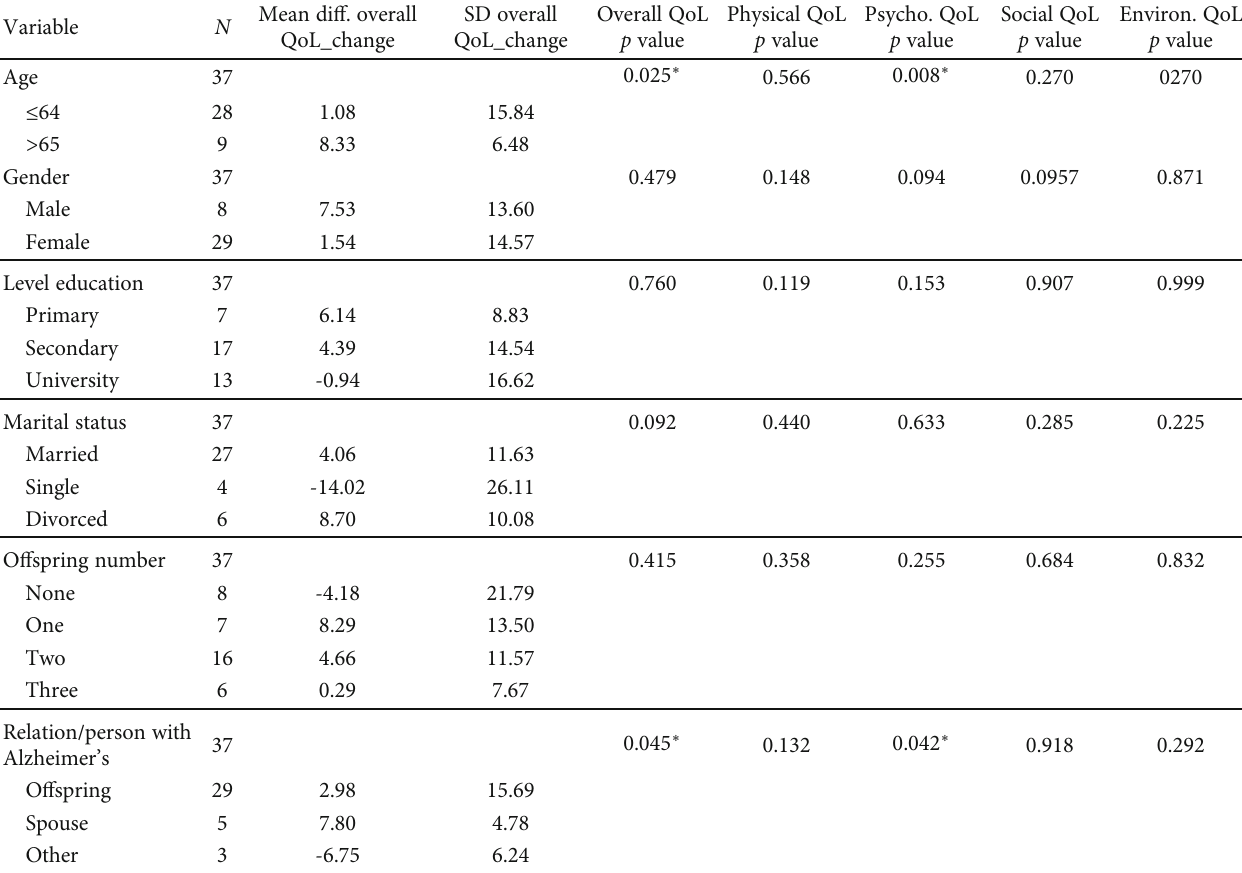
Table 4: Statistical di ff erences between qualitative caregivers ’ variables and QoL.